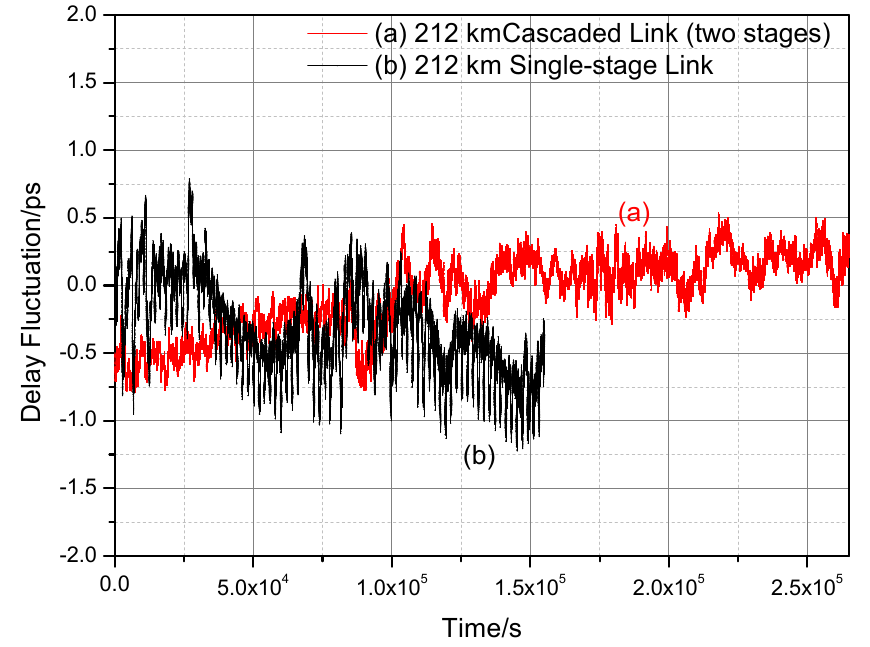
Figure 7. Delay fluctuation of the cascaded dissemination system. In Figure 8, curve (a) shows the stability of the 10 GHz dissemination system, which was 3.06 × 10 − 15 at 1s and 2.34 × 10 − 17 at 10 4 s. Curve (b) shows the stability of the 9 GHz dissemination system, which was 3.03 × 10 − 15 at 1s and 1.39 × 10 − 17 at 10 4 s. Curve (c) shows the stability of the 10 GHz to 3.6 GHz low-noise frequency conversion (LN frequency